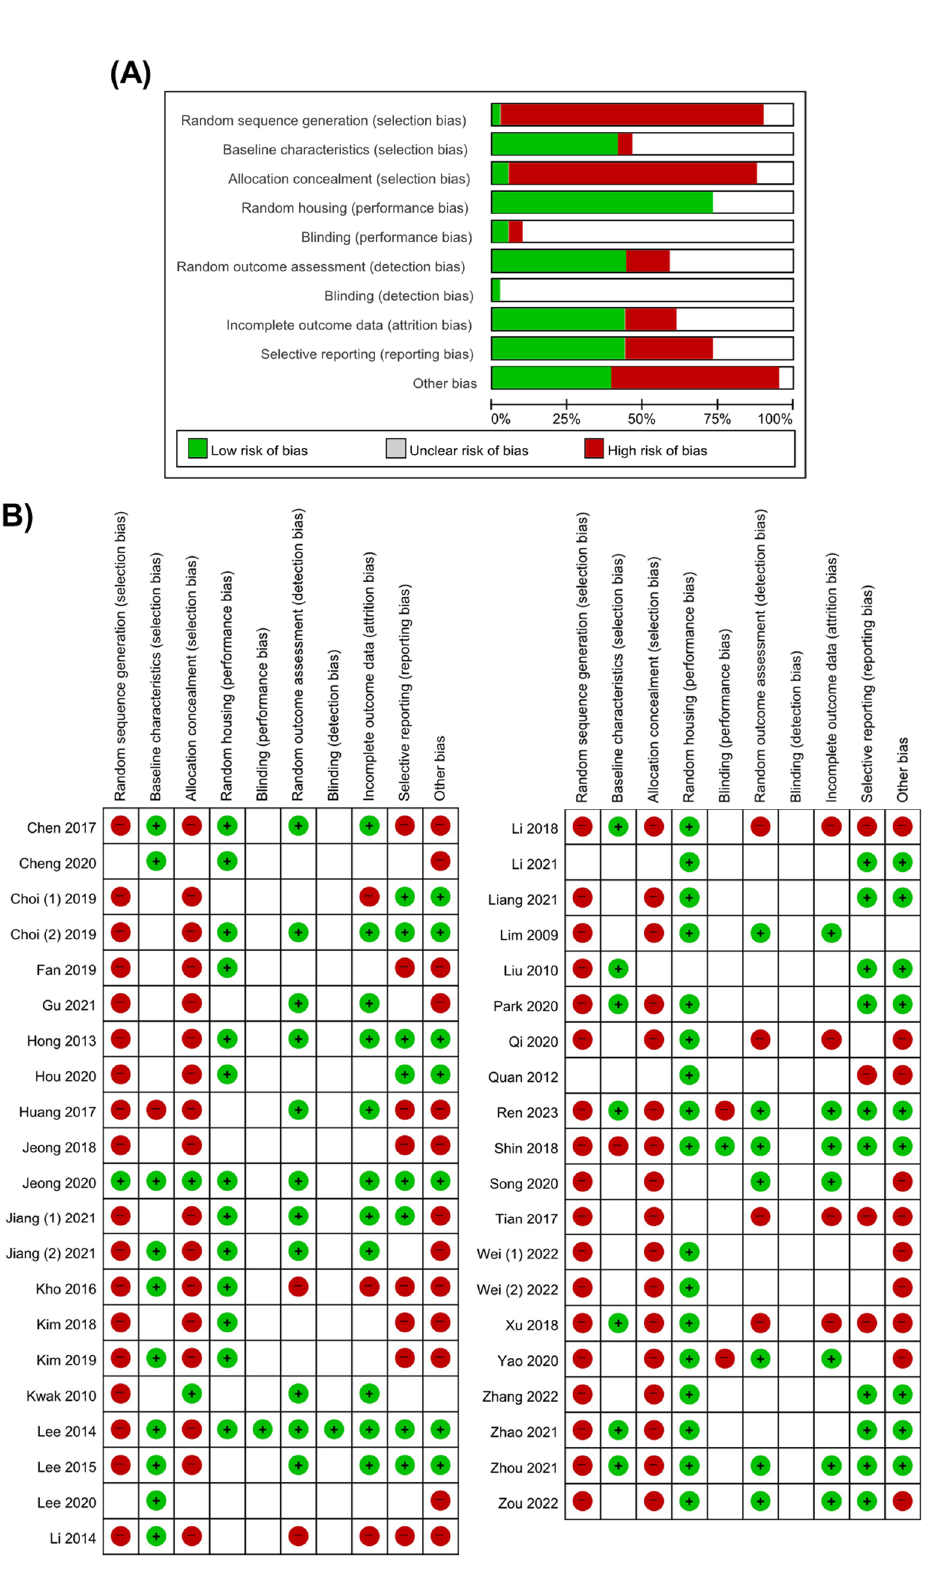
Figure 2. Quality assessment of included studies based on the SYRCLE’s risk of bias tool. ( A ) A graph of the risk in the bias of included studies. ( B ) A summary of the risk of bias in the included studies [7,19–58].